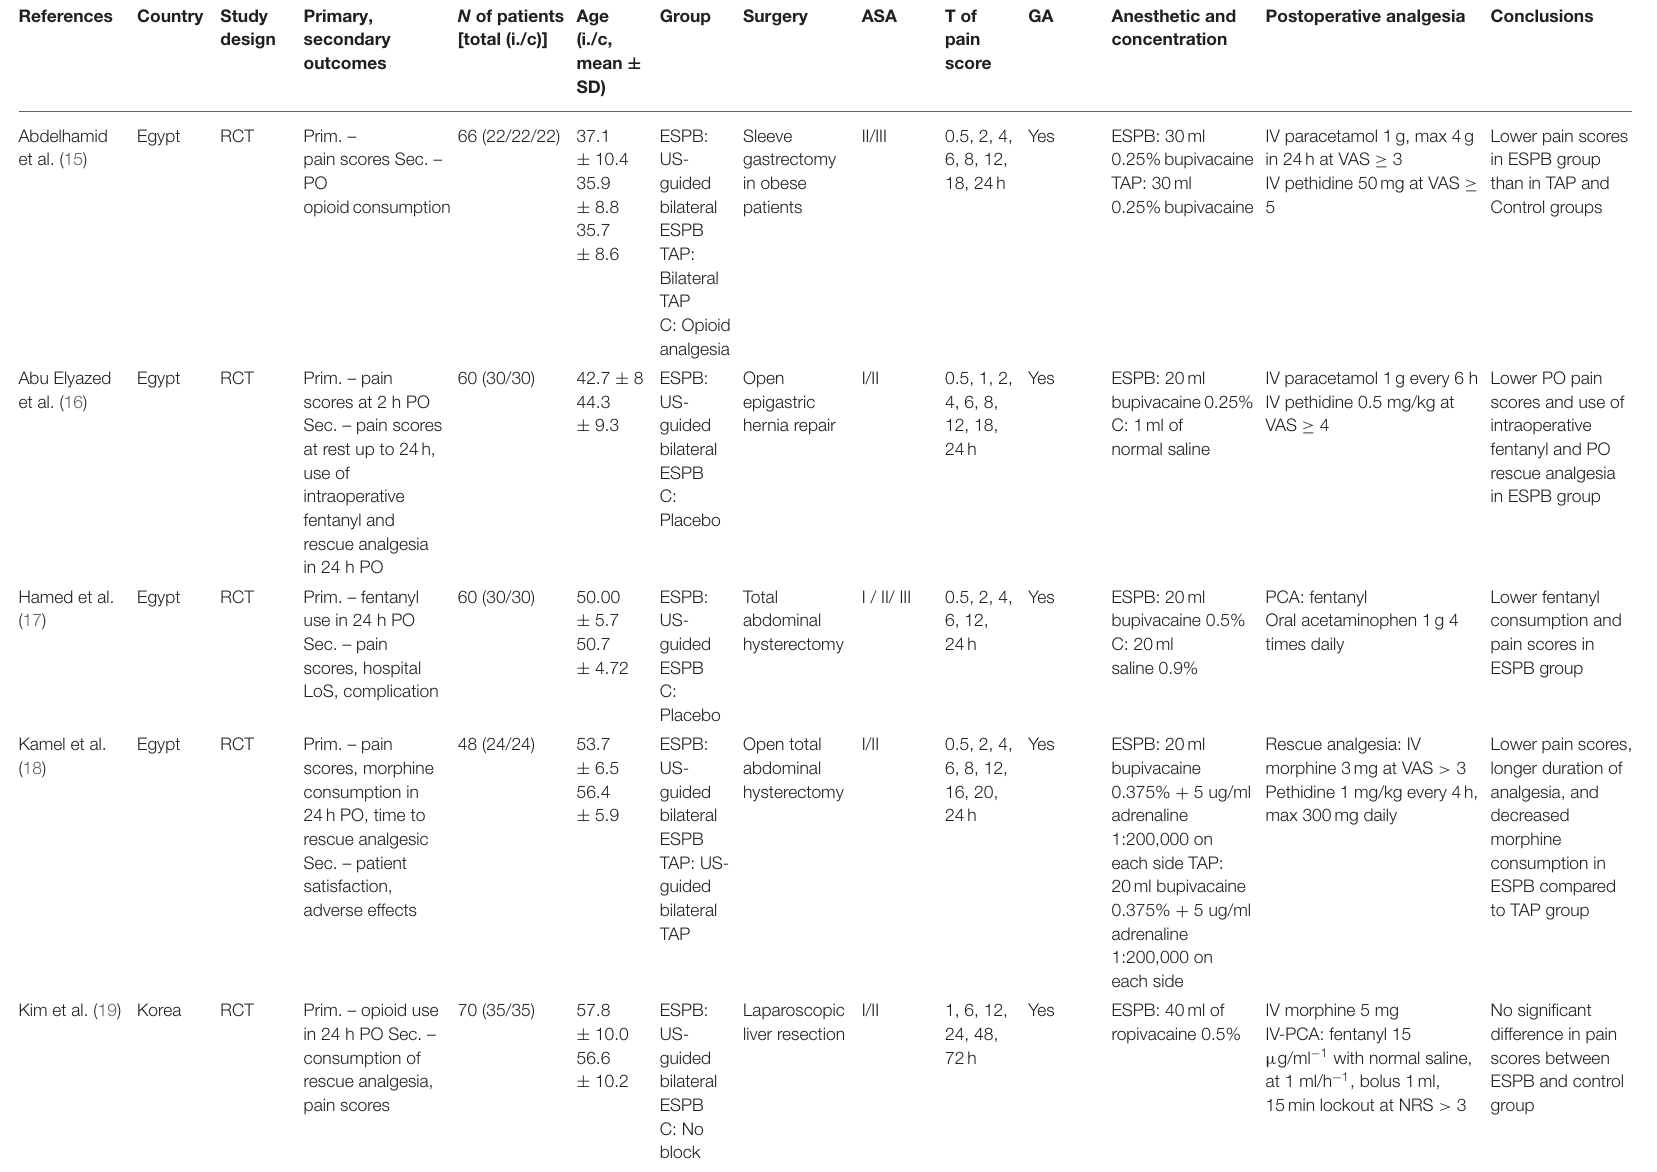
TABLE 1 | Characteristics of the included